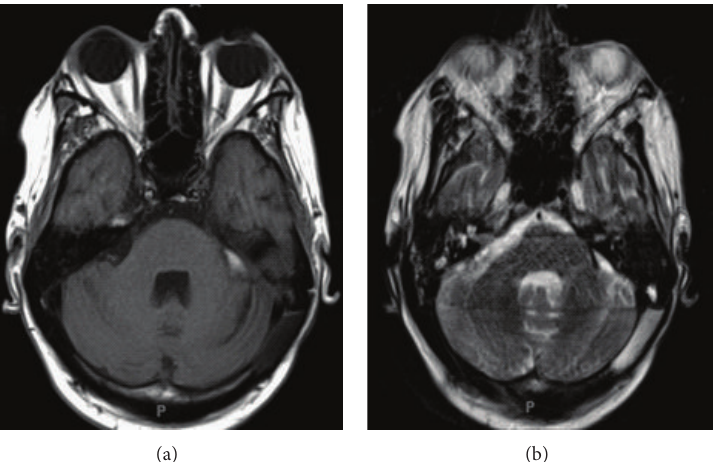
Figure 4: (a) T1-axial MRI with contrast and (b) T2-axial Flair MRI demonstrating interval decrease in size of previously identified enhancing mass in the left cerebellopontine angle after